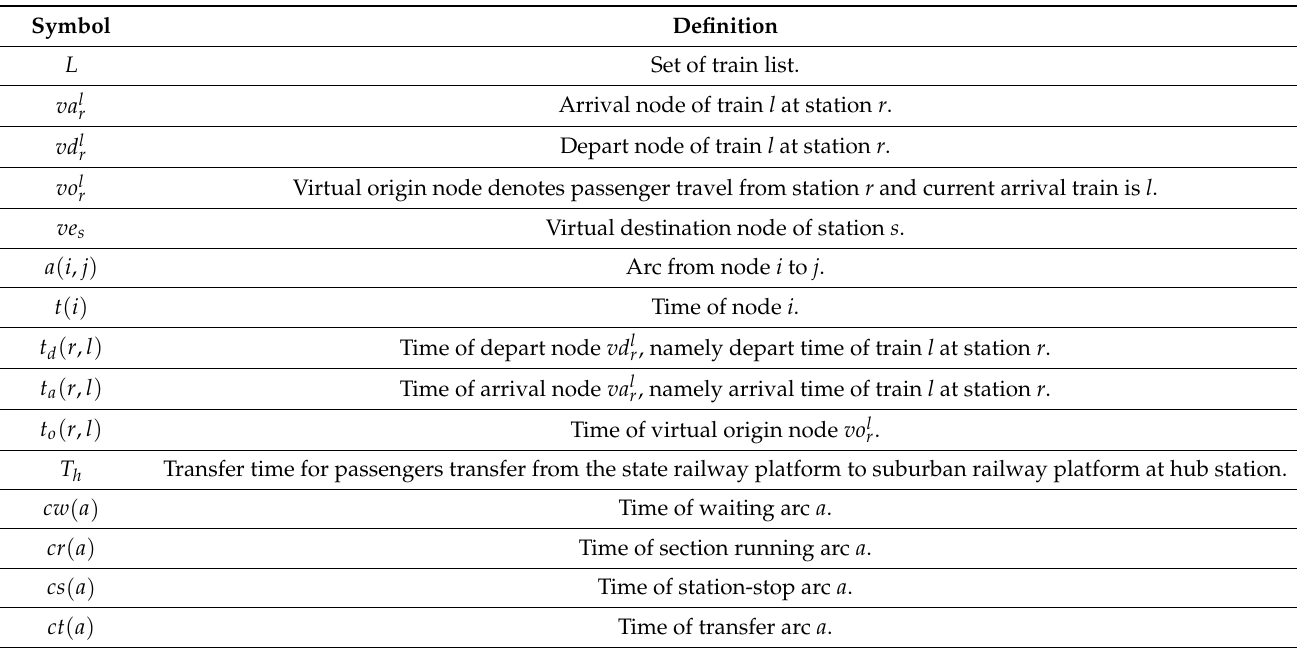
Table 1. Schedule-based network related